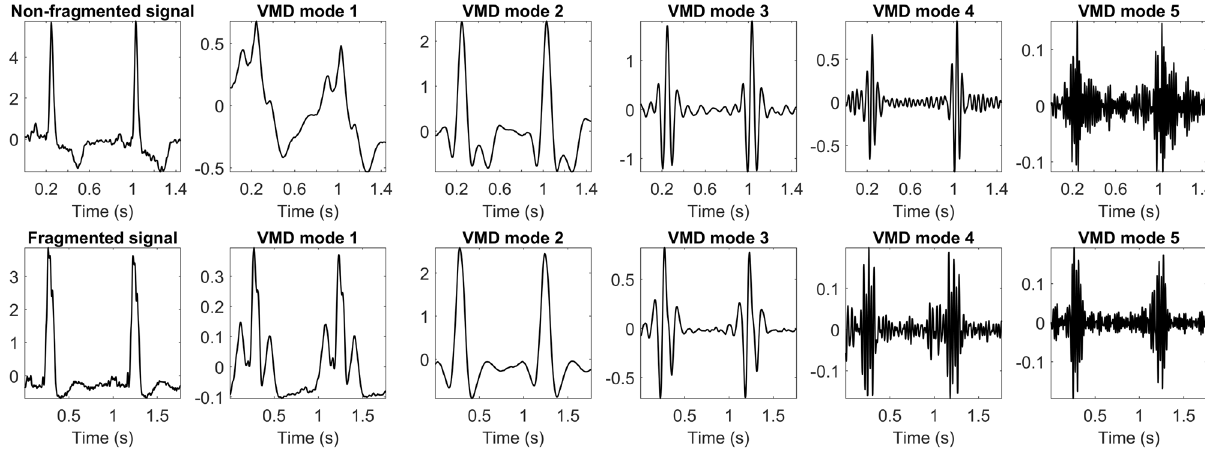
Figure 3. Examples of the VMD decomposition of non-fragmented (upper row) and fragmented (lower row) QRS complexes. Modes 1 to 5 are sorted in increasing frequency.